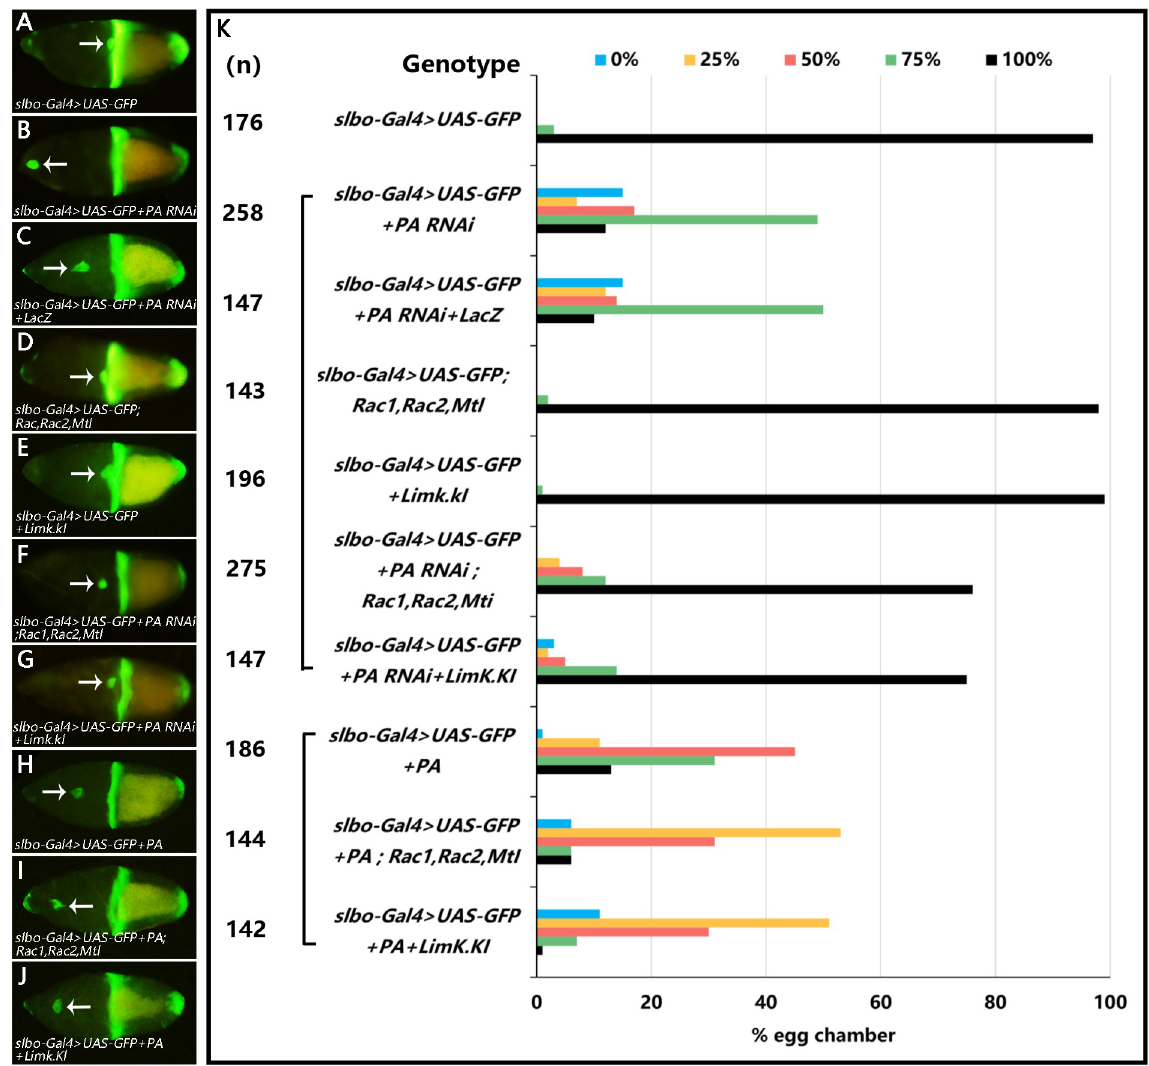
Fig 4. Genetic rescue of migration defects in RhoGAP18B-PA knockdown in border cells by Rac mutant or LimK.KI. (A-J) Stage 10 egg chambers of labeled genotypes show the slbo-Gal4 expression patterns by GFP (Green). The arrows show the positions of the border cell clusters. (K) Quantitation of border cell migration. The x-axis denotes the percentage of stage 10 egg chambers for each genotype with each degree of migration. The extent of migration for all stage-10 egg chambers examined is measured as 0–5% (blue, no migration), 6–25% (yellow), 26–50% (pink), 51–75% (green), 76–100% (black, complete migration). The number of egg chambers examined for each genotype is given (n). Note that reducing the function of Rac or LimK can rescue the migration defects caused by PA RNAi expression and enhance the migration defects caused by PA